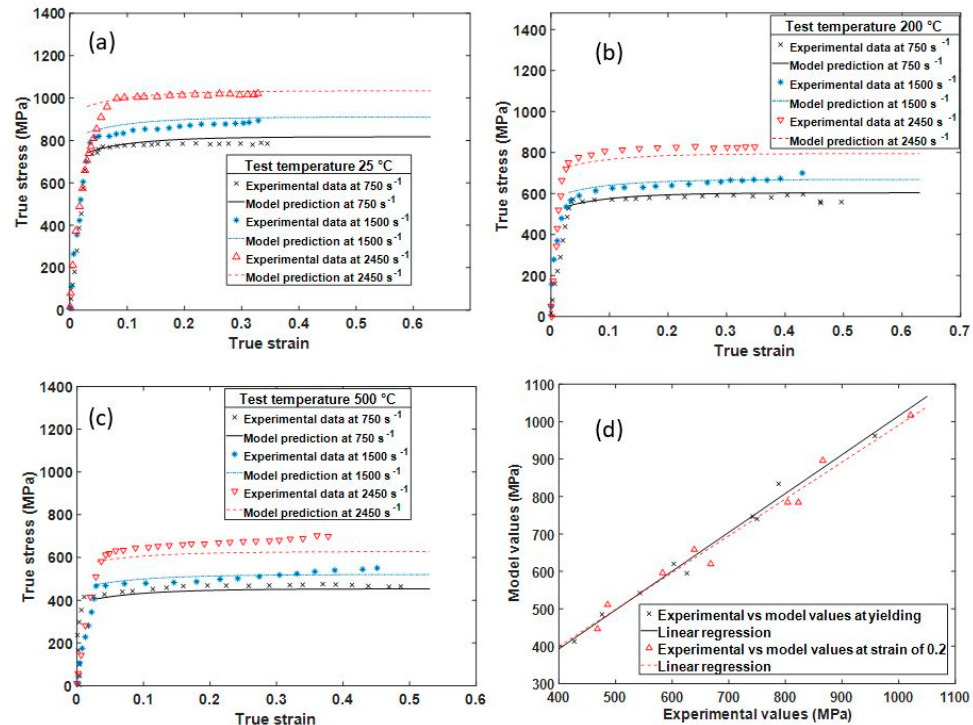
Figure 13. Comparison of the modified model prediction and experimental results for sample E at three high strain rates and at test temperatures of ( a ) 25 °C, ( b ) 200 °C, and ( c ) 500 °C, and ( d ) the correlation between the predicted values and those obtained from experimentation at yielding and at a strain of 0.2.